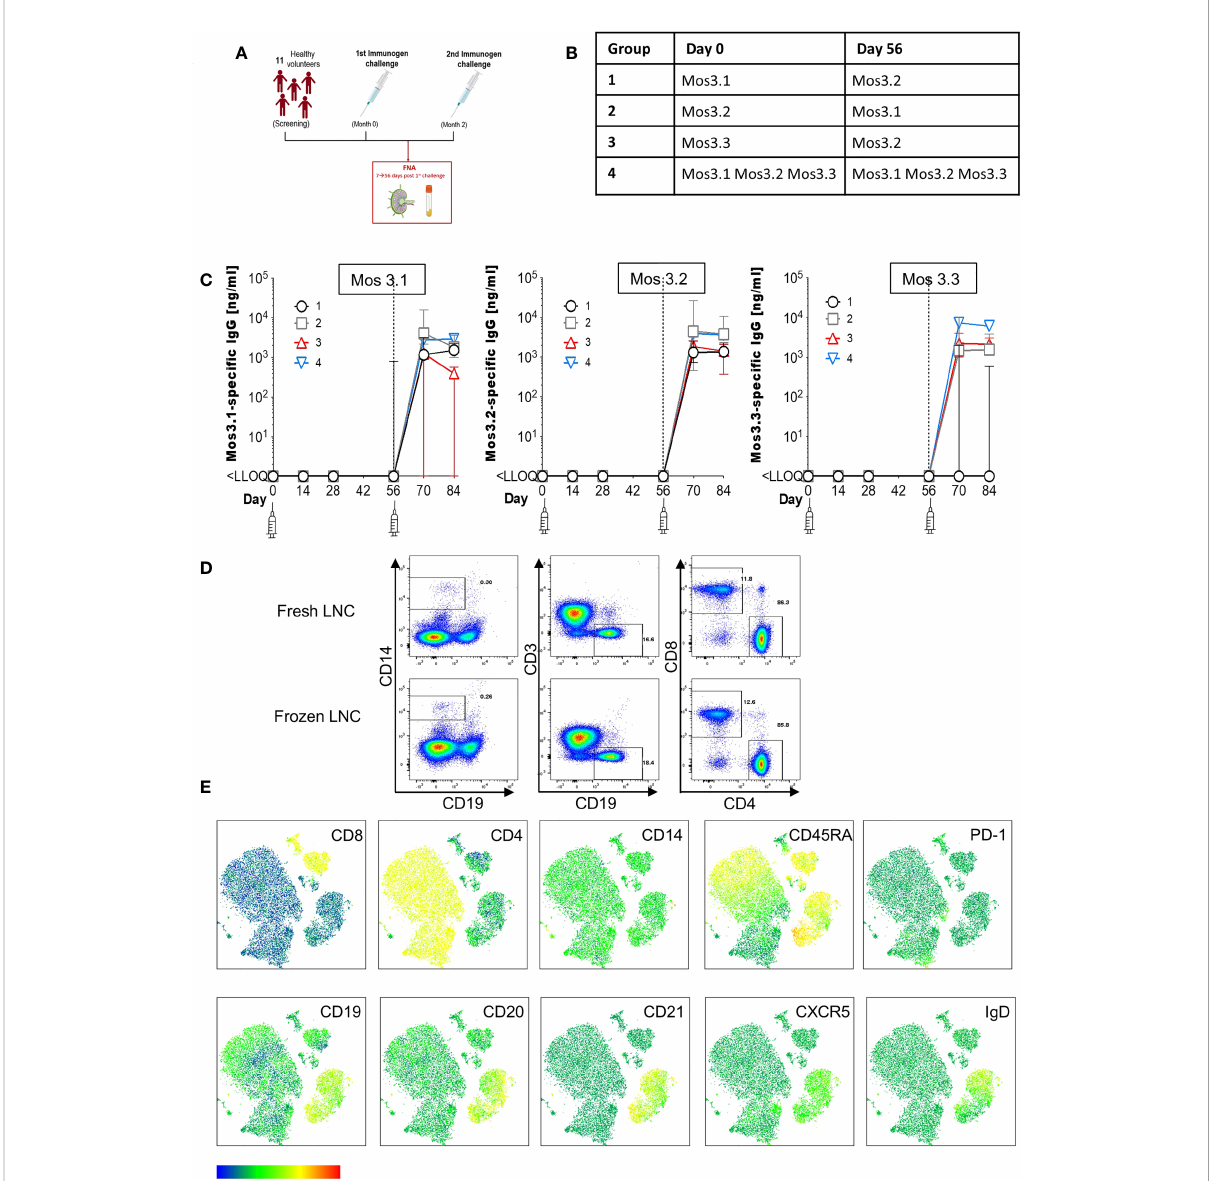
FIGURE 1 Induction of HIV-speci fi c antibodies and lymph node cell yields after injection with HIV Mosaic immunogens. (A) Study overview: 11 participants chose to join the lymph node study and proceeded to sampling. All participants except one (who had the FNA after the second injection) had the lymph node FNA after the fi rst study injection. (B) The schedule of injections for the EAVI2020_01 study for groups 1 to 4 is shown where participants were challenged with a single HIV Mosaic immunogen (Mos 3.1, 3.2 or 3.3) at a dose level of 100 µg or a cocktail of all three (group 4) at 33 µg coupled with a liposomal MPLA adjuvant. (C) Detection of HIV-speci fi c IgG in serum of individuals after receiving two injections with HIV immunogens. Responses at six timepoints during the study are shown in the 11 participants who underwent FNA. Graphs show IgG in ng/ mL against Mos 3.1 (left panel), Mos 3.2 (middle panel) and Mos3.3 (right panel) at baseline, between prime and boost doses, and after the boost dose at Day 56. Responses from participants in each group are shown with group 1 black circles (n=3), group 2 grey squares (n=3), group 3 red triangles (n=3) and group 4 blue inverted triangles (n=2). (D) Comparison of fresh and frozen lymph node cell composition: LNC from one participant were either stained at once (top row), or viably cryopreserved, thawed and then stained (bottom row) with a cocktail of 15 cell surface phenotyping markers before fi xing with fi xation buffer. Events were acquired on a BD Fortessa fl ow cytometer. Events were gated according to immunophenotyping to de fi ne major cellular subsets in LNC for CD14+CD19- monocytes (left panel), CD19+CD3- B cells (middle panel) and CD4+ and CD8+ T cell populations (right panel). Up-stream gating of cells was on the lymphocyte population with doublet (FSC-A/ W, SSC-A/W) and dead cell exclusion (not shown). (E) FlowSOM clusters were obtained based on typical phenotyping markers. Expression of CD8, CD4, CD14, CD45RA, PD-1, CD19, CD20, CD21, CXCR5 and IgD is shown on each FlowSOM cluster for frozen LNC imposed on a t-SNE representation. The scale of expression is shown in the heatmap legend from low (blue) to high (red). Cell types enriched for expression of each marker are visible in the light green to orange color range. Clusters were derived from events acquired from a fi ne needle aspirate of frozen LNC as described